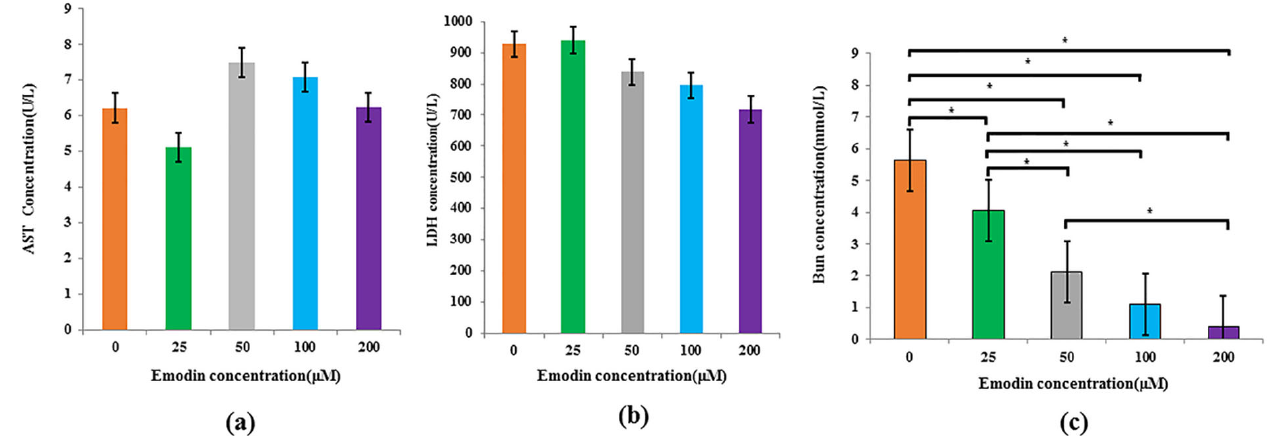
Figure 6. Effects of emodin at different concentrations (0, 25, 50, 100, and 200 μ M) on metabolic indexes of HepG2 cells model based on microfluidic chip. ( a ) The AST activity; ( b ) LDH level; ( c ) BUN content; * multiple comparisons, p < 0.05.